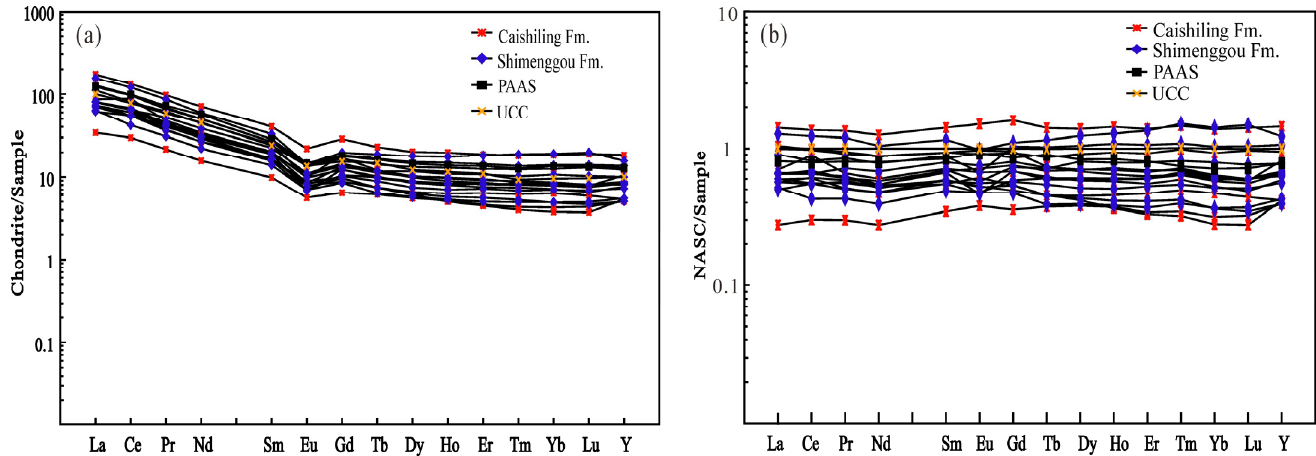
Figure 4. ( a ) The standard REE curve of chondrites for Jurassic sandstones at the Yuqia uranium occurrences (data from Sun and McDonough [29]), and ( b ) normalized curves for North American shales (NASC; data from Haskin and Paster [30]).